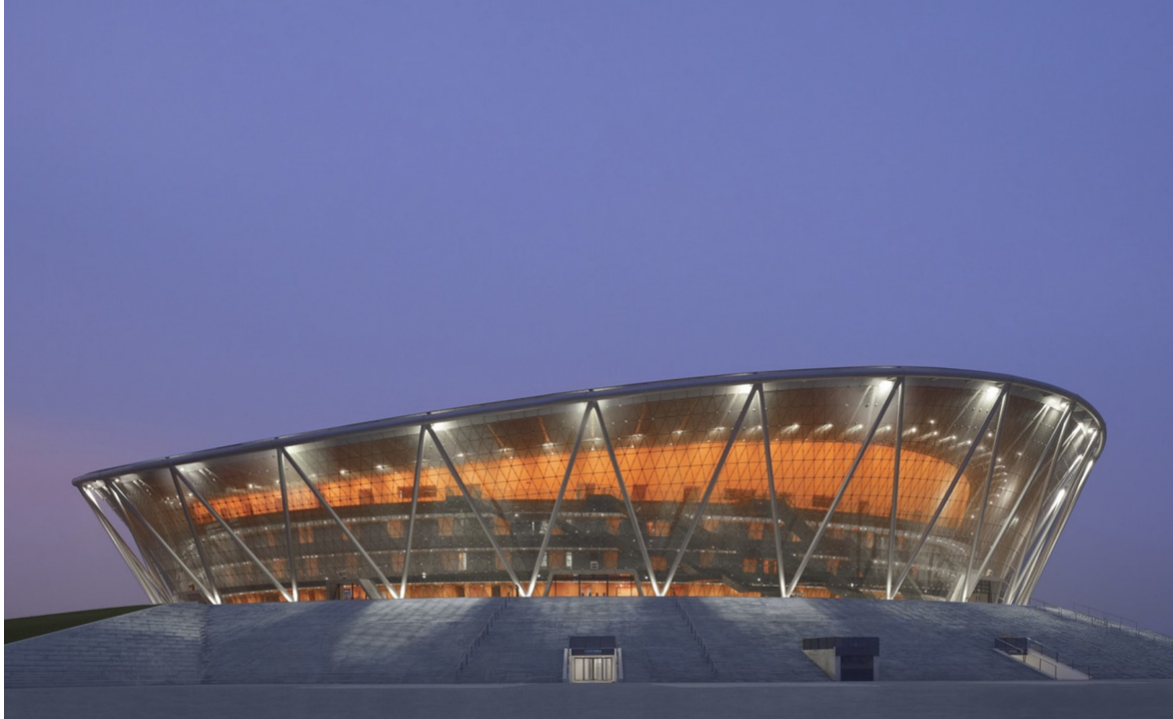
Fig. 1. Dongguan gymnasium,